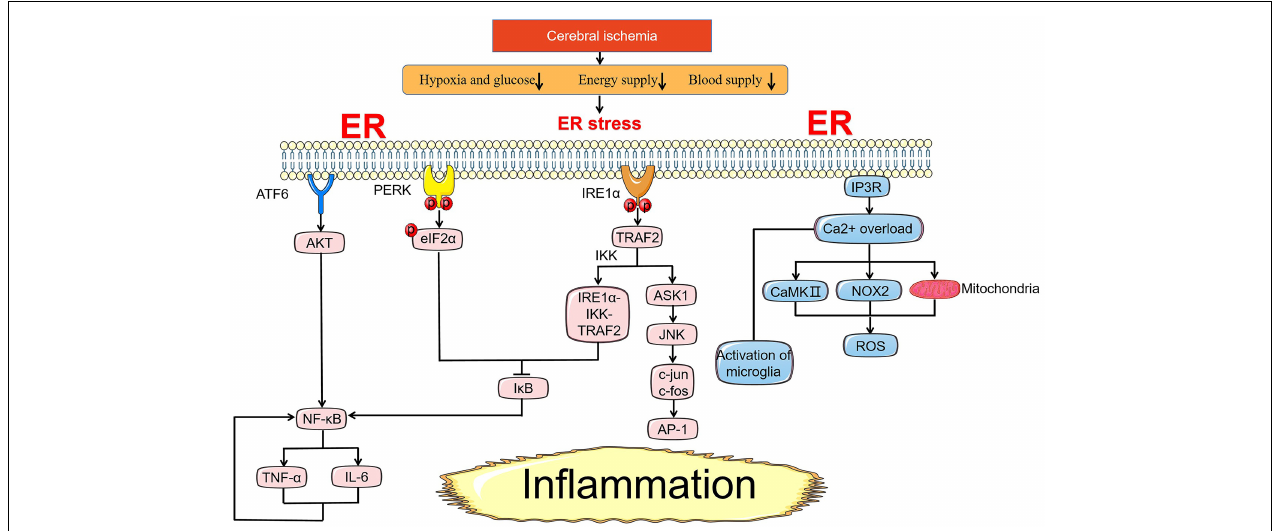
FIGURE 3 | ER stress-mediated inflammation pathway under cerebral ischemia. Under ischemic state, NF- κ B is an essential pivot in the inflammation pathway induced by ER stress. NF- κ B is controlled by the activation of AKT and suppression of inhibitory I κ B proteins. NF- κ B and TNF- α promote each other casing nausea cycle of inflammation response. In addition to NF- κ B, the release of inflammatory factors induced by IRE1 α -TRAF2-JNK axis is also a crux part of the injury mechanism in cerebral ischemia. Ca 2 + overload from the ER through NOX2-dependent, subsequent activation of CaMKII and mitochondria pathway lead to the generation of ROS involving in inflammation response. Reactive microglia are mainly expressed as M1 pro-inflammatory type with Ca 2 + overload after I/R